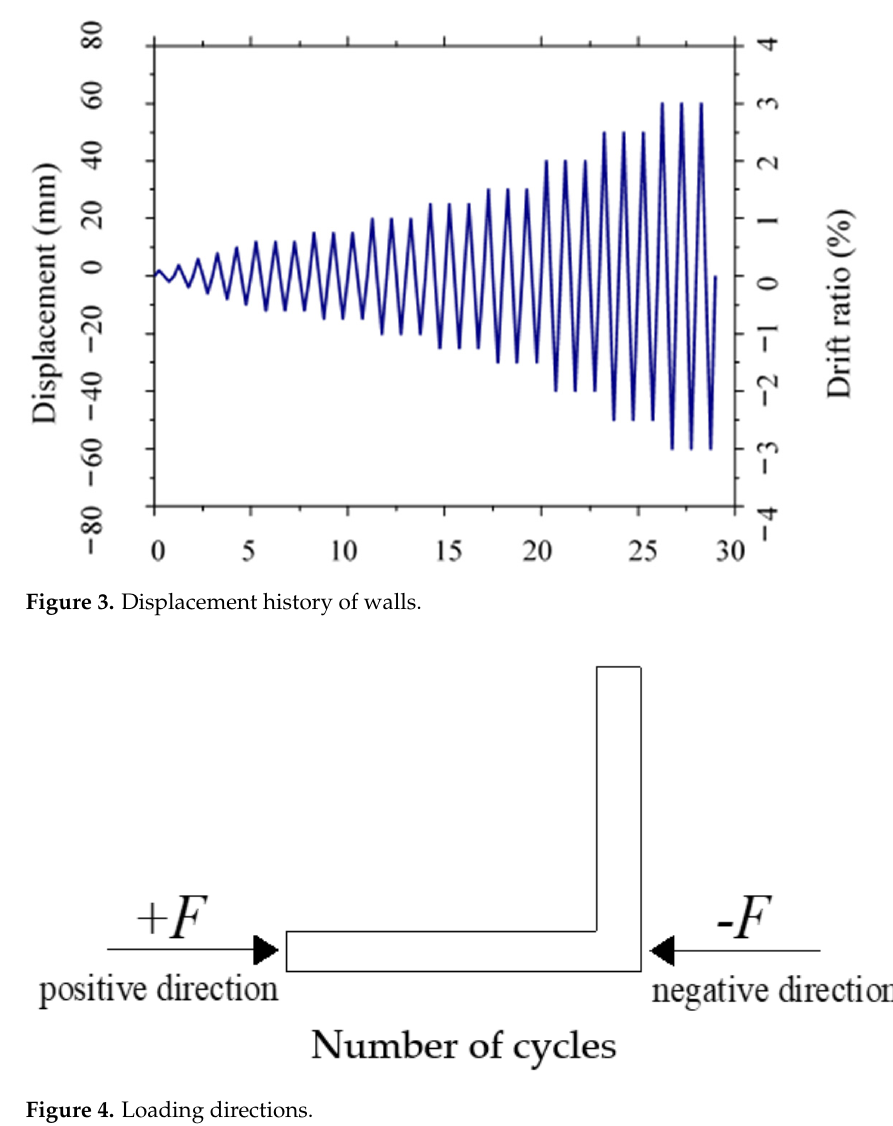
Figure 4. Loading directions. Figure 4. Loading